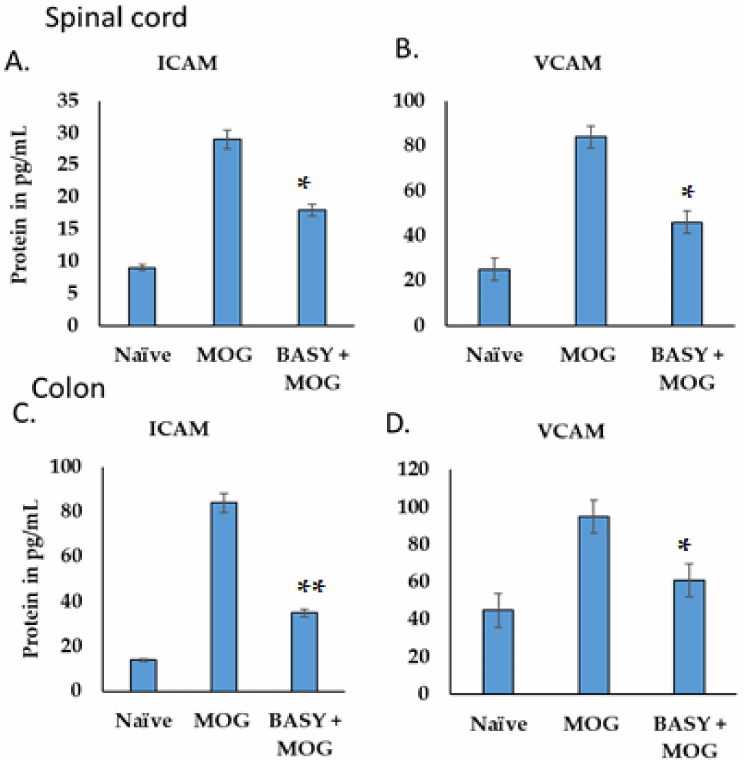
Figure 7. The cell adhesion molecules regulated by BASY treatment in MOG-induced mice. The spinal cord and colon tissues were homogenized and endothelial cell adhesion molecules VCAM and ICAM were quantified using a protein specific ELISA Kit: ( A , B ) the differential expression of ICAM and VCAM in the spinal cord after MOG immunization was reduced by BASY treatment; ( C , D ) the expression and regulation of the invasion of lymphoid cells from the intestinal lamina propria to the peripheral lymph nodes of the spinal cord was quantified. Data were pooled from three independent experiments and shown as mean ± SD. * p < 0.05. ** p < 0.01 (n = 5). ICAM—intracellular adhesion molecule-1; VCAM—vascular cell adhesion